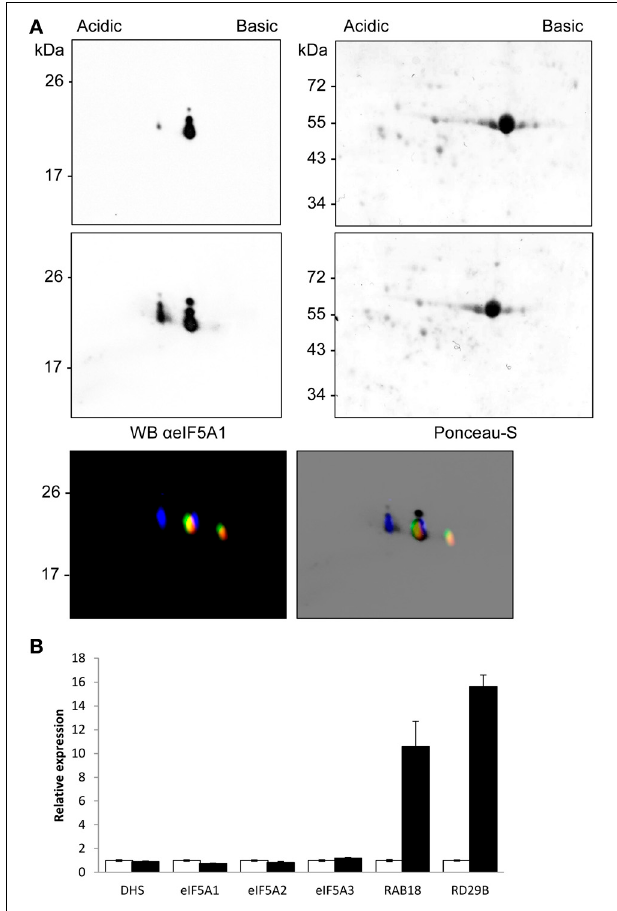
FIGURE 6 | ABA-dependent post-transcriptional inhibition of eIF5A1 hypusination. The immunological profile of separated Arabidopsis eIF5A proteins was checked after ABA treatment. Control samples (upper Panel A ) were compared to 10 μ M ABA treated seedlings for 3h (middle Panel A ) and the mobility compared with fluorescent imaging of fluorescent labeled recombinant hypusine-modified eIF5A proteins (lower Panel A ) as in Figure 5 . The same amount of total protein from both samples was separated by 2D-E and, after Ponceau-S staining showing similar amount of Rubisco protein, the blots were used for western blot analysis with anti-eIF5A1 antibody. The western blots represent a typical result of three independent biological replicates. Panel (B) shows RTqPCR gene expression analysis with the same samples used for the proteomic analysis shown in (A) . Total RNA from control samples (white bars) and ABA-treated samples (solid black bars) were used for RTqPCR to check expression changes of eIFA genes and hypusination coding-enzyme genes together with ABA-inducible genes RAB18 and RD29B ; the data were referred for each gene to the non-treated control